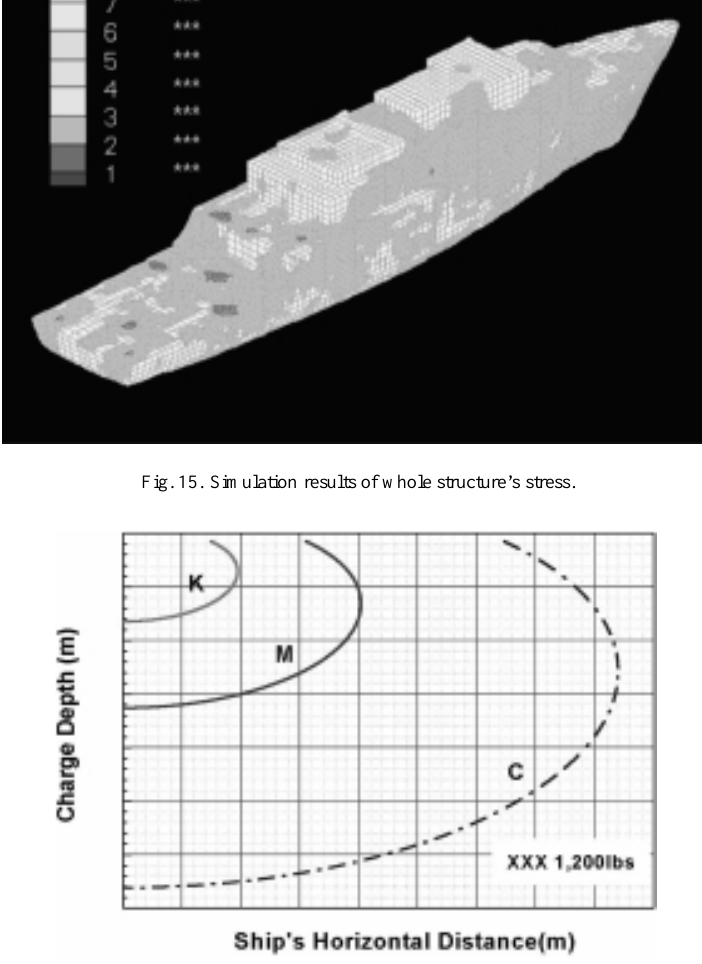
Fig. 16. Damage estimation due to charge weight and